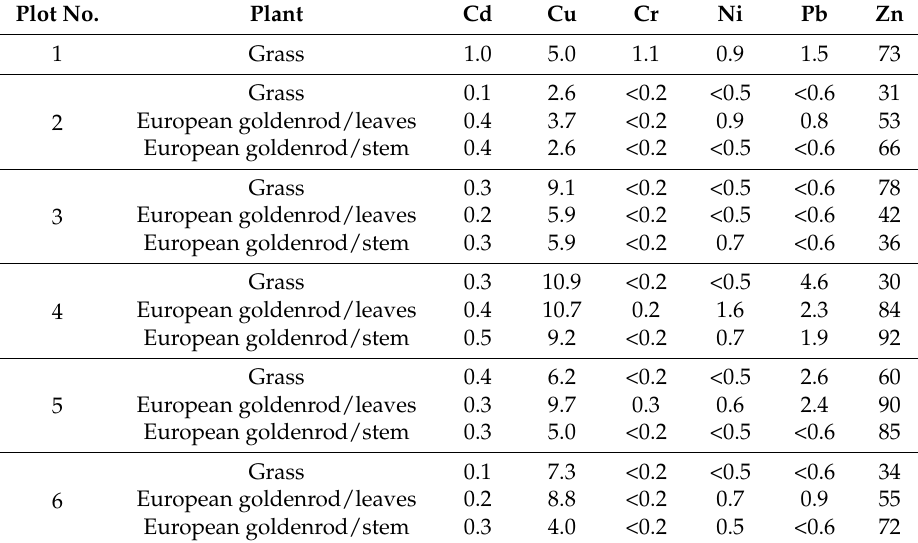
Table 4. Contents of heavy metals in European goldenrod ( Solidago virgaurea L.) and grasses (Poaceae) in the area of the MSW Łubna landfill